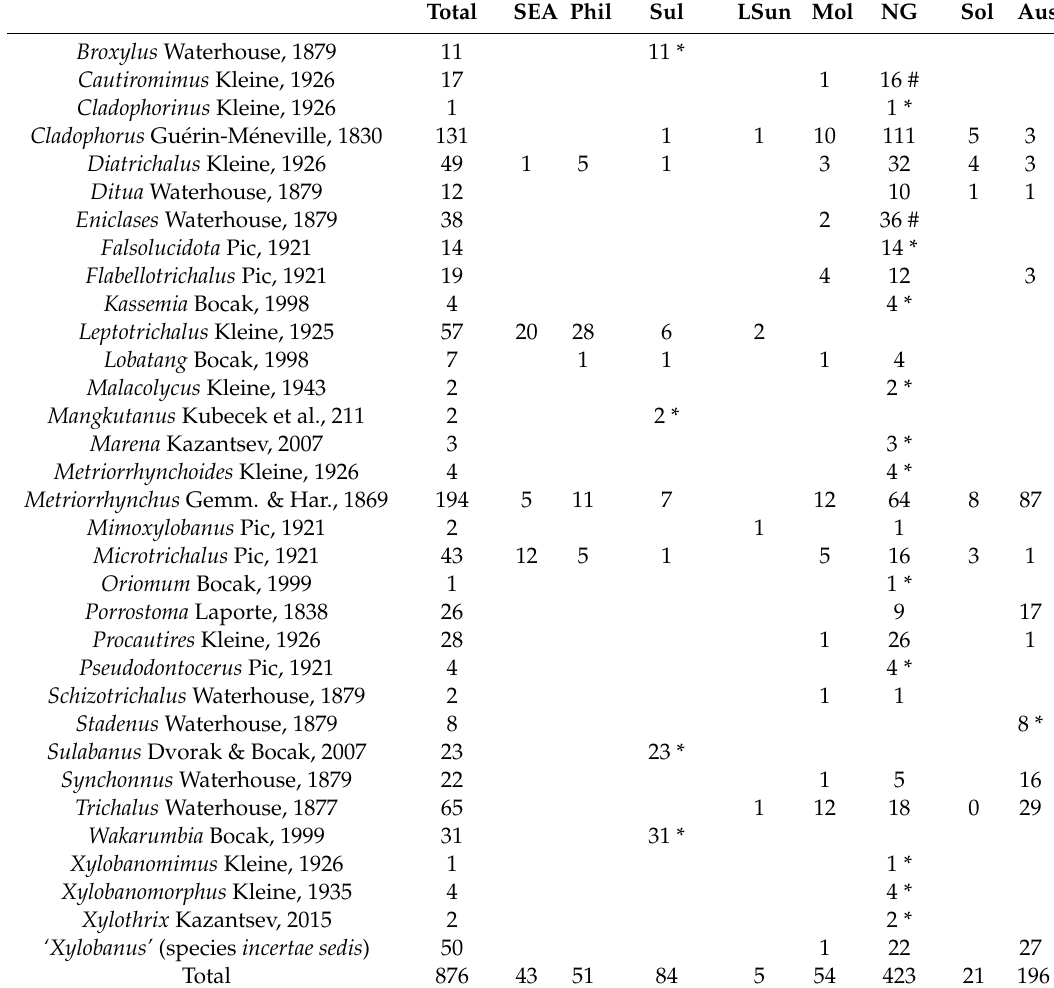
Abbreviations for delimited